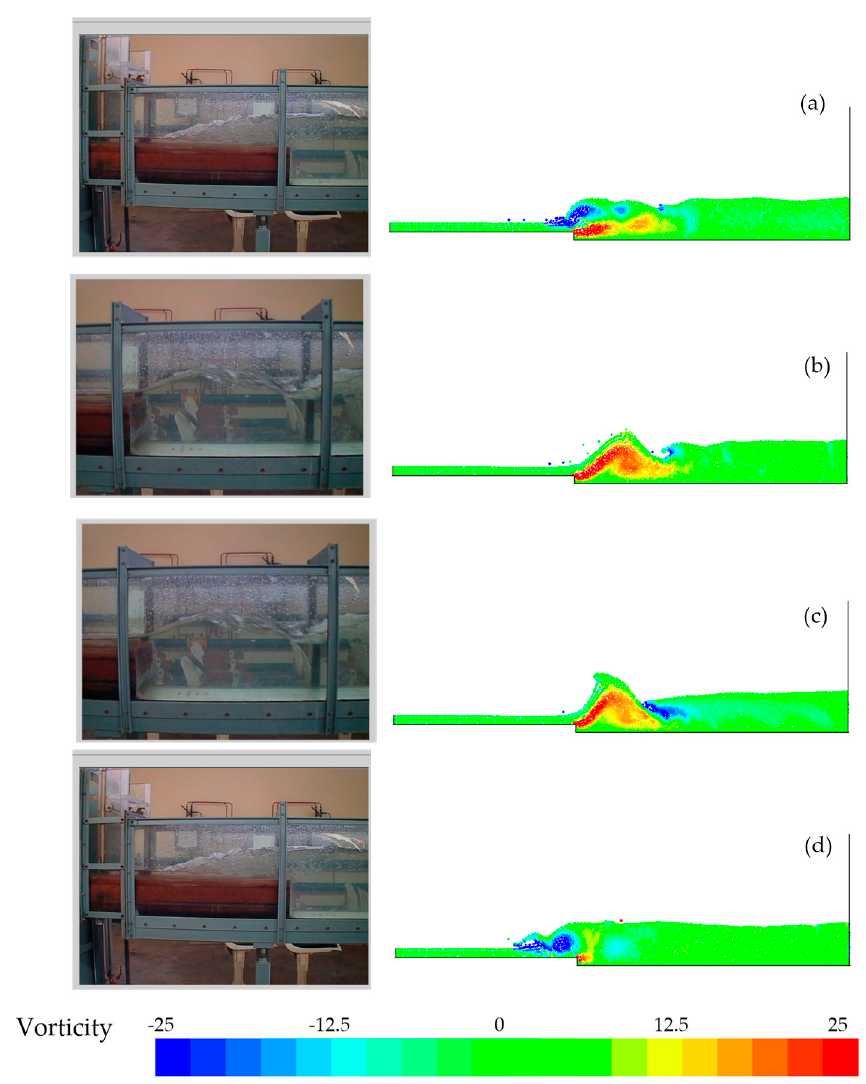
Figure 7. SPH vorticity field; oscillatory flow patterns between A-jumps and wave jumps: ( a ) t = 2 s; ( b ) t = 4 s; ( c ) t = 8.5 s and ( d ) t = 11.5 s.